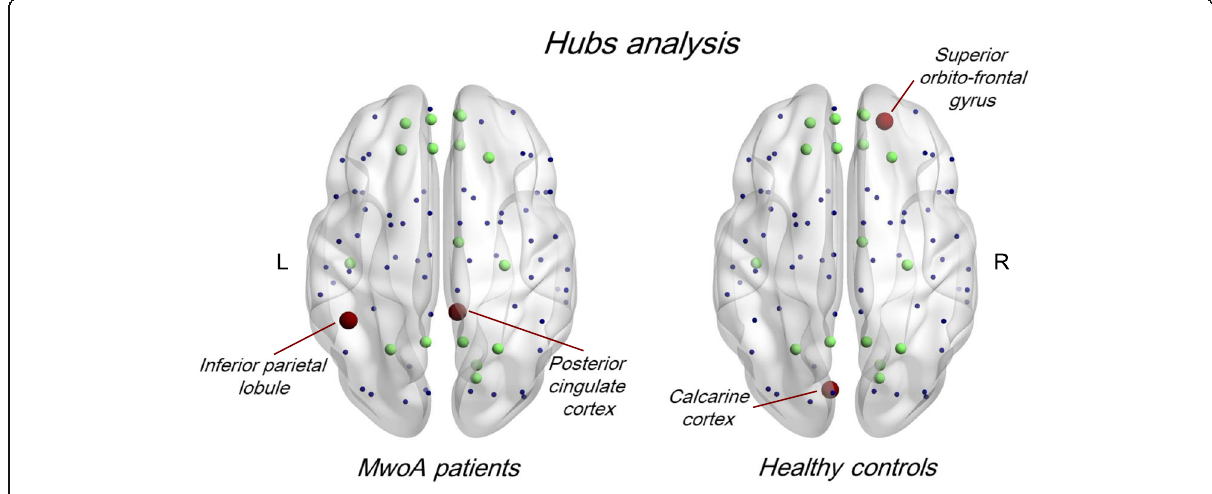
Fig. 5 Hubs regions with groups betweenness centrality scores in the 80th percentile displayed on brain on MNI template surface. Red spots: hubs exclusively in MwoA patients or HC acquisition schemes. Green spots: common hubs in MwoA patients and HC acquisition schemes. Blue dots: common nodes in MwoA patients and HC acquisition